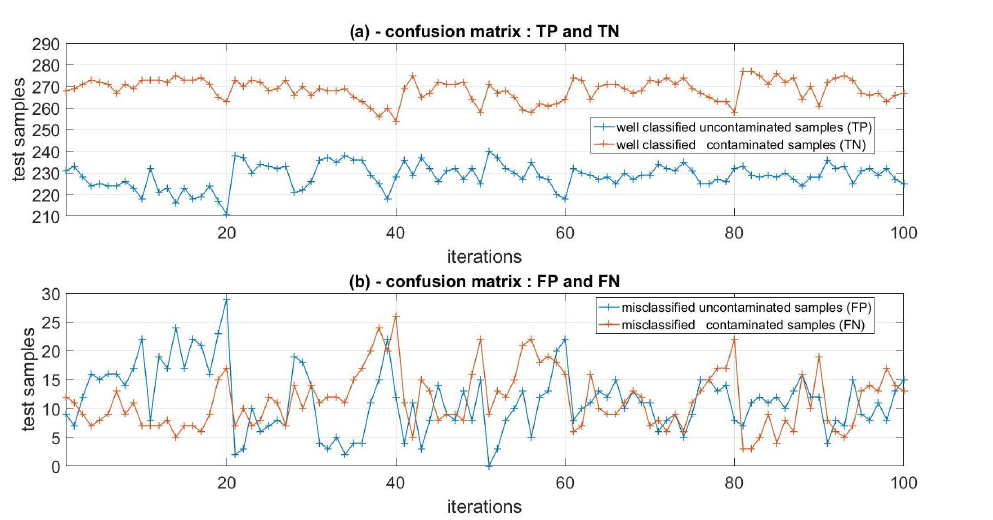
Figure 8. Confusion matrices obtained by the MLP classifier trained on Magnitude only dataset. Curve ( a ) shows the plot of the well classified terms TP and TN, while curve ( b ) is the plot of the misclassified terms FP and FN.